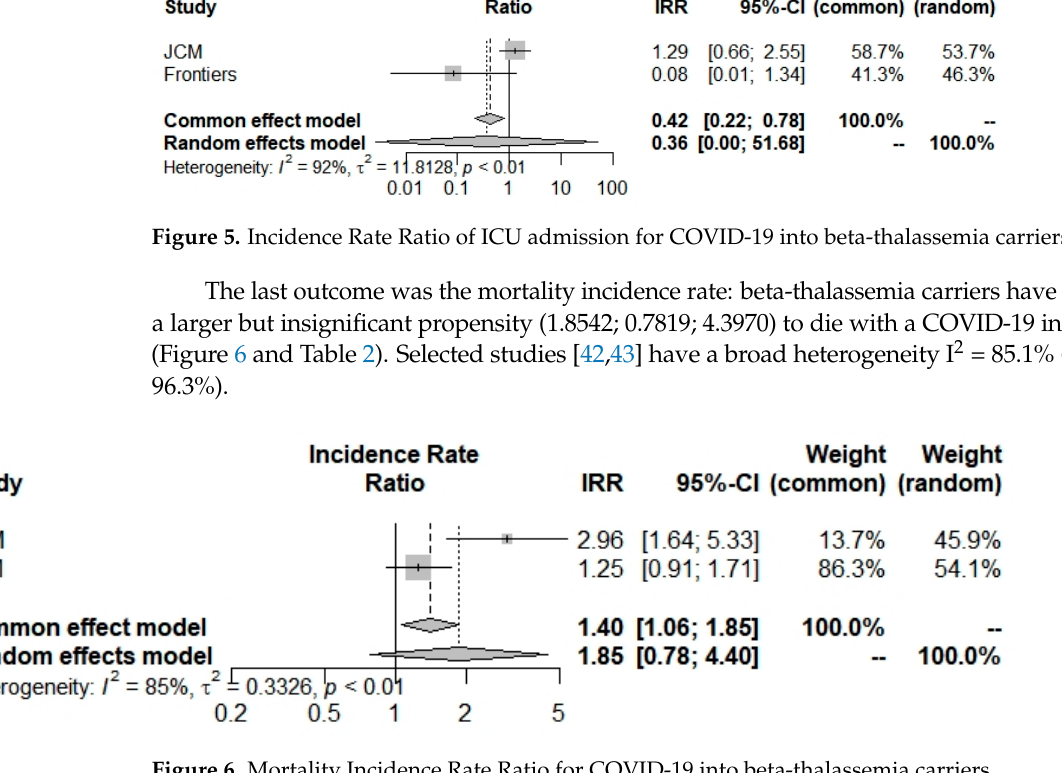
Figure 6. Mortality Incidence Rate Ratio for COVID ‐ 19 into beta ‐ thalassemia carriers.